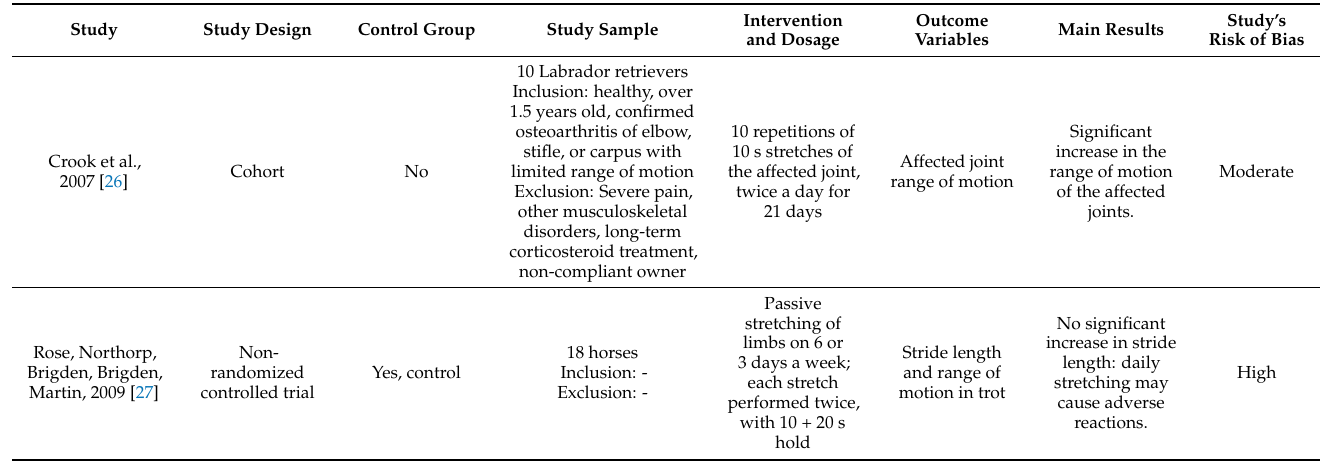
Table 2. Summary of stretching techniques based on a systematic review of published